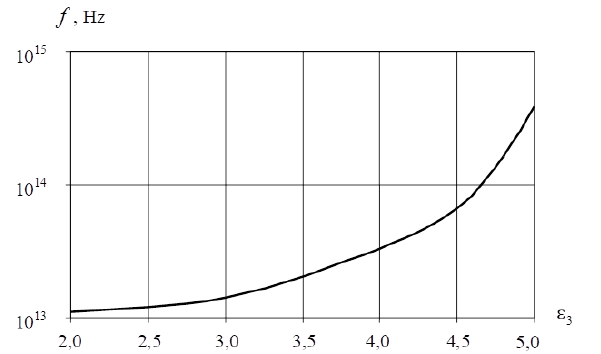
Fig. 4. Dependence of oscillation frequency on resonator radius. –––– dielectric resonator.